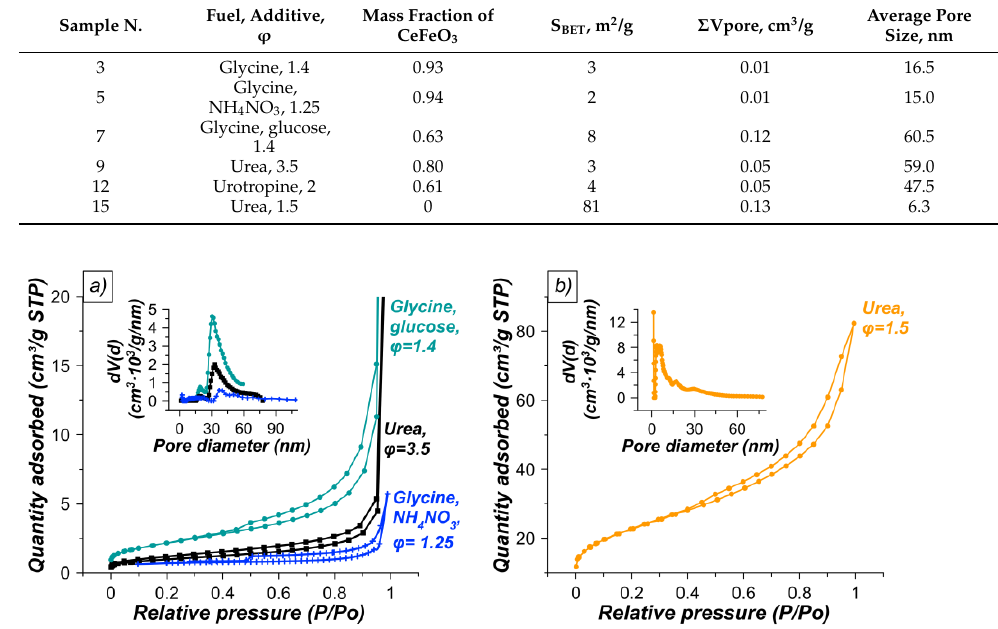
Figure 7. Temperature-programmed reduction (TPR) spectra of the SCS-products calcined at 330 – 350 °C. For all samples, the presence of free iron oxide was noted, although in different amounts. It is well known that the reduction of Fe 2 O 3 proceeds via Fe 3 O 4 (magnetite) and FeO (wüstite) to iron [53 – 55]. The formation of FeO is often not observed since it is meta- stable and disproportionates into Fe 3 O 4 and Fe below 620 °C [56]. According to the authors of [53], in the stepwise reduction of iron oxide, the experimental TPR profile of Fe 2 O 3 con- tained two peaks at 394 and 545 °C, which correspond to Fe 3 O 4 and FeO + Fe, respectively. The ratio of the area of the first peak to the area of the second peak should be close to 1:8.